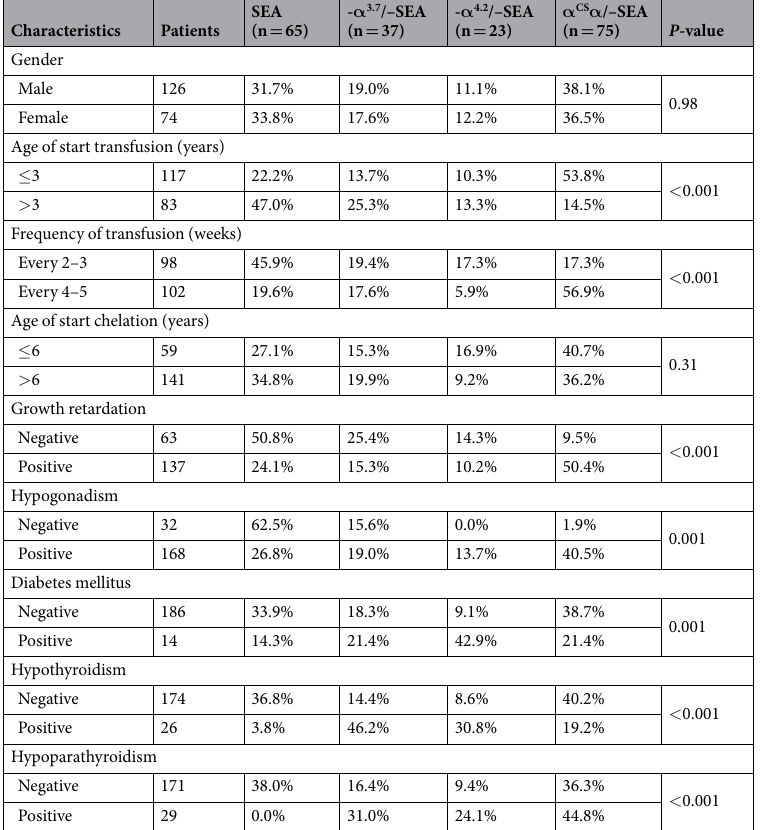
hypogonadism and diabetes mellitus (100% and 73.9%, respectively) (Table 2). Growth retardation in patients.